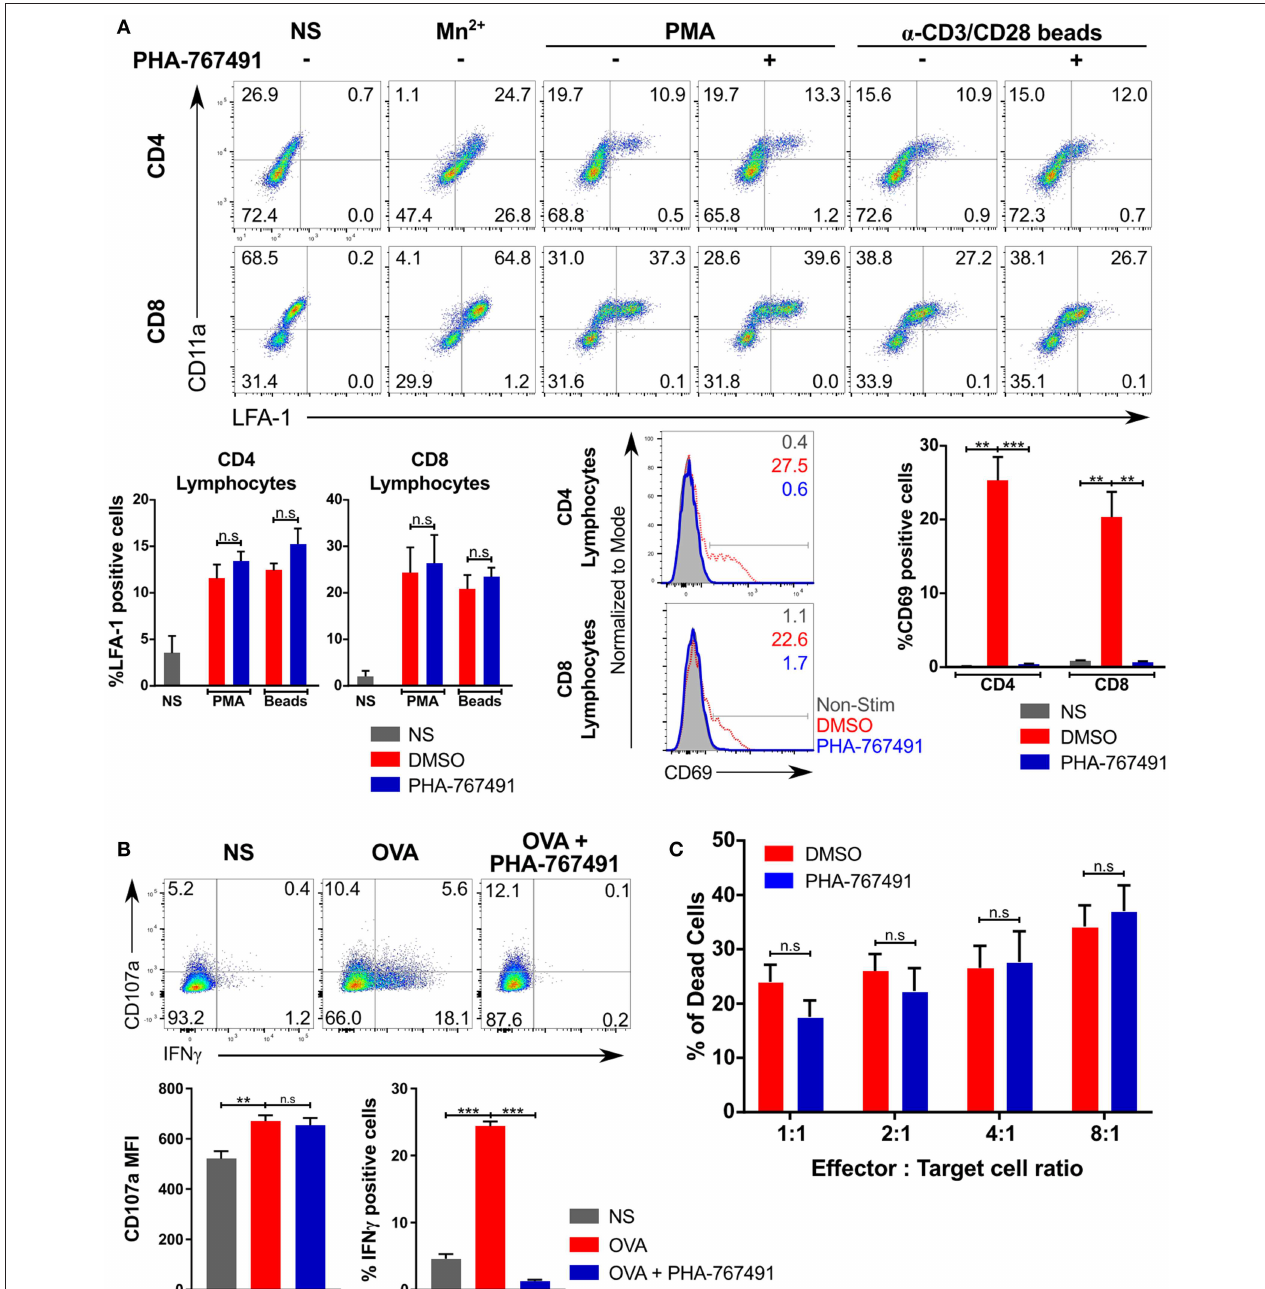
FIGURE 5 | Effector functions not inhibited by PHA-767491. (A) PHA-767491 does not block LFA-1 conformational change. Human PBMCs were stimulated with PMA or anti-human CD3/CD28 beads for 0.5 and 3h, respectively, and incubated with anti-LFA-1 antibody during the stimulation period. Mn 2 + was used as a positive control for LFA-1 activation. The percentages of each quadrant in each graph are shown. PHA-767491 suppresses expression of CD69 in human T lymphocytes that were stimulated with anti-human CD3/CD28 beads for 3h. (B) PHA-767491 does not impair degranulation in OT-I CTL. CTL were pre-treated with BFA for 30min and stained with anti-CD107a antibody during the stimulation with APCs expressing single chain H-2K b with OVA peptide for 6h. The percentages of each quadrant in each graph are shown. (C) PHA-767491 does not dampen cytotoxicity of OT-I CTL. CTL that were serum-starved overnight were treated with either DMSO or PHA-767491 for 30min before co-culturing with CTV-labeled and OVA-pulsed EL4 cells for 6h. The bar charts compare the percentage of dead EL4 target cells, which were gated based on positive staining for the Live/Dead stain and negative staining for resazurin. Data shown is representative of at least three independent experiments. Bar charts are represented as mean ± SEM. Statistical significance was determined by unpaired two-sided Student’s t -test (n.s, non-significant; ** p < 0.01; *** p < 0.001).